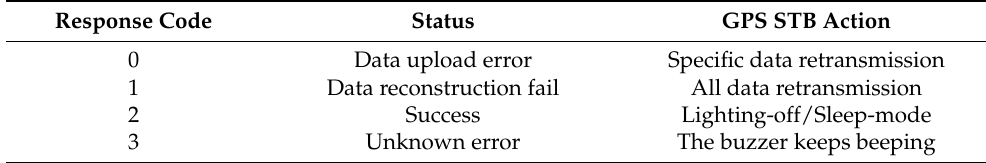
Figure 7. GPS data transfer format. Table 2. Background data system return code status table and actions. Table 2. Background data system return code status table and actions.